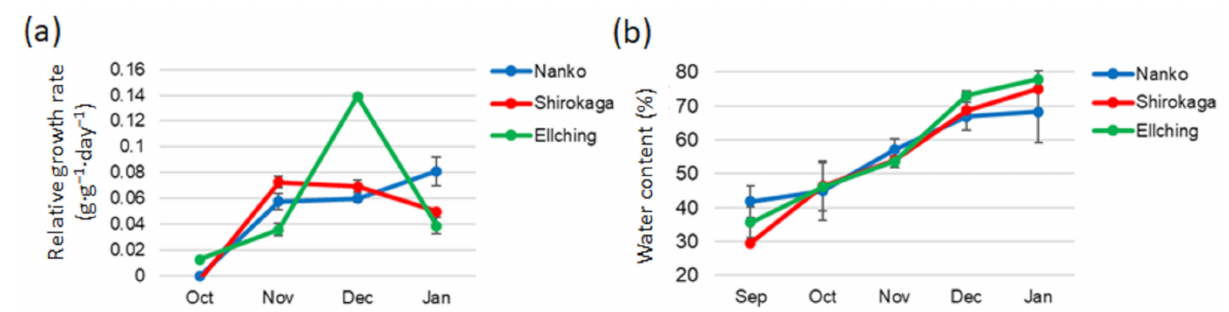
Figure 5. Seasonal changes in the relative growth rate and the water content during dormancy in 2019–2020. ( a ) Relative growth rate. ( b ) Water content (%). ‘Nanko’, high chill; ‘Shirokaga’, extra high chill; ‘Ellching’, low chill. Four replicates were analyzed, and 20 flower buds were examined for each replicate. The error bars represent the